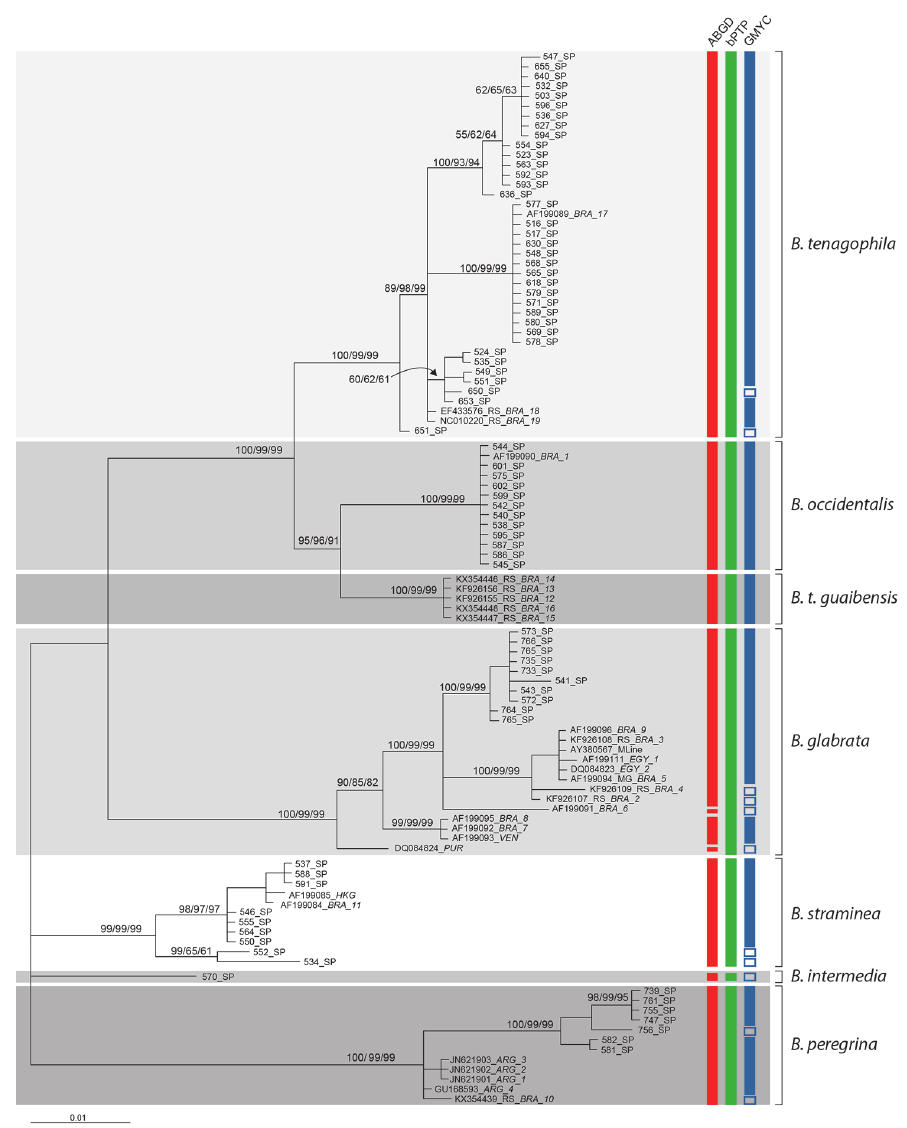
Figure 3. Bayesian phylogram. Support values for individual branches are given as Bayesian credibility/ ML bootstrap/NJ bootstrap and are depicted above each node. The different shades of gray identify mor- phological species. The red, green and blue bars indicate species delimitations based on the distance-based (ABGD) and tree-based (bPTP and GMYC) models,